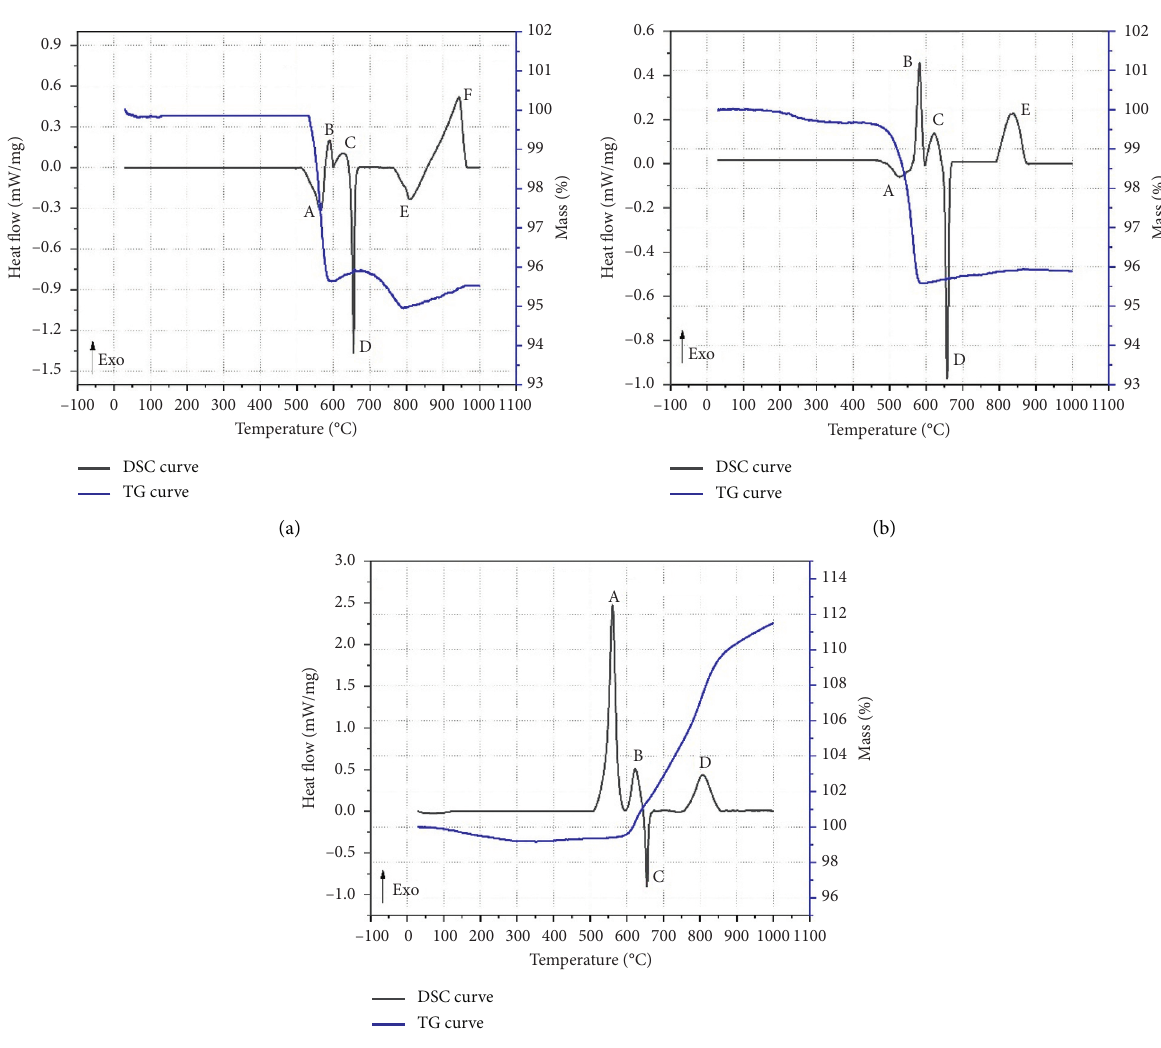
Figure 6: TG-DSC curves of thermite samples with different Al particle sizes: (a) 5 μ m Al +micron-MnO Al +micron-MnO 2 thermite sample, and (c) nano-Al+micron-MnO 2 thermite